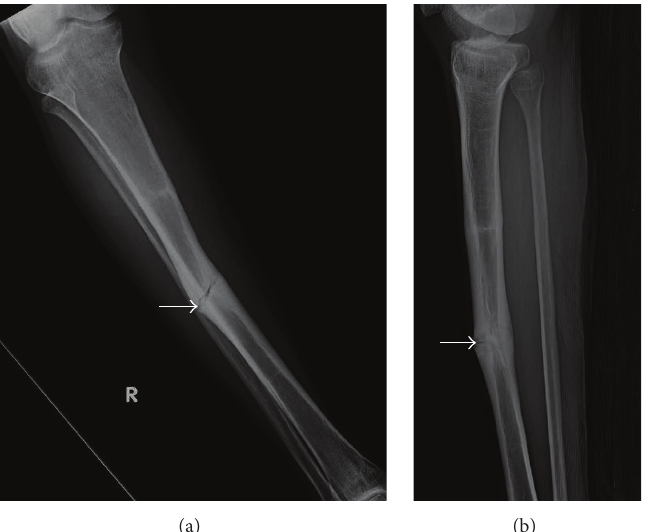
Figure 7: Young adult male with history of Rothmund-Thomson syndrome diagnosed at 2 years of age. Findings: (a) recurrent mildly displaced mid tibia diaphyseal fracture through the area of tibia fracture 9 years earlier (arrow). (b) Mildly displaced fracture of the mid tibia diaphysis again seen. There is increased cortical thickening of the mid tibia diaphysis (arrow). Technique: (a) AP radiograph kVp = 57, mAs = 3, and (b) lateral radiograph kVp = 57, mAs = 3.